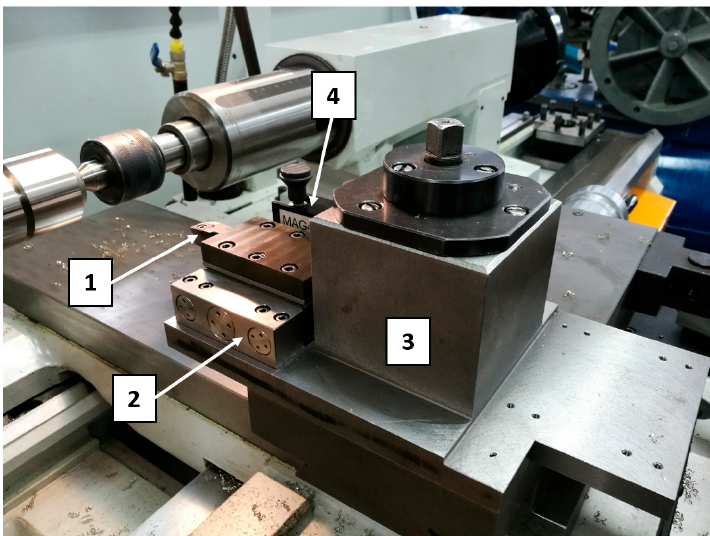
Figure 2. The equipment used in research: 1-tool, 2–dynamometer, 3–dynamometer grip, 4–acoustic emission sensor with holder.